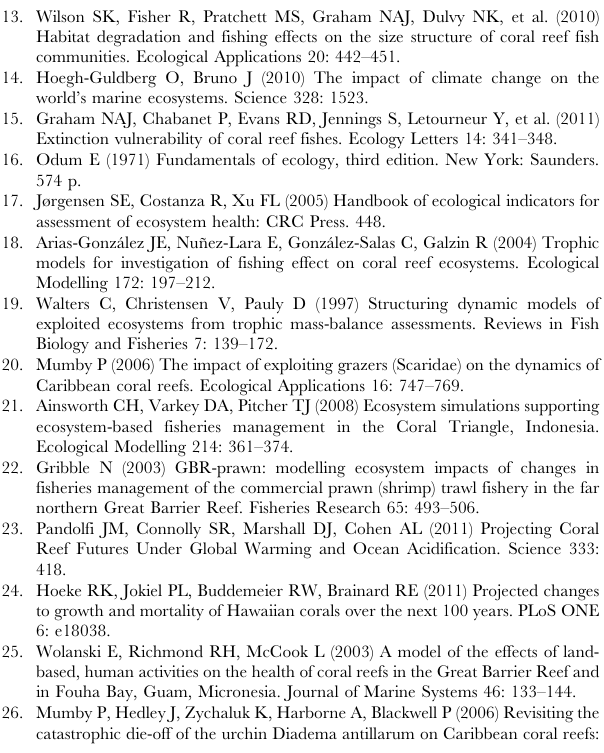
habitats (CRED unpubl. data). Table S3 Ecopath input data and resulting parameters for the 33 functional groups for French Frigate Shoals. Values calculated by EwE are shown in bold. (TIF) Table S4 Ecopath input data and resulting parameters for the 33 functional groups for the Kona Coast. Values calculated by EwE are shown in bold. (TIF) Table S5 Ecopath input data and resulting parameters for the 33 functional groups for O’ahu. Values calculated by EwE are shown in bold. (TIF) Table S6 Diet composition matrix of the functional groups included in a reef system around French Frigate Shoals. Import indicates feeding outside of the modeled area. Numbers in column headings (predators) correspond with numbers in row headings (prey), e.g., group 19 represents corals. The sum of the diet composition (column) equals to 1. CCA is crustose coralline algae. Column headings correspond to the row headings. (TIF) Table S7 Diet composition matrix of the functional groups included in a reef system along the Kona Coast of Hawai’i. Import indicates feeding outside of the modeled area. Numbers in column headings (predators) correspond with row numbers (prey). The sum of the diet composition (column) equals to 1. CCA is crustose coralline algae. Column headings correspond to the row headings. (TIF)